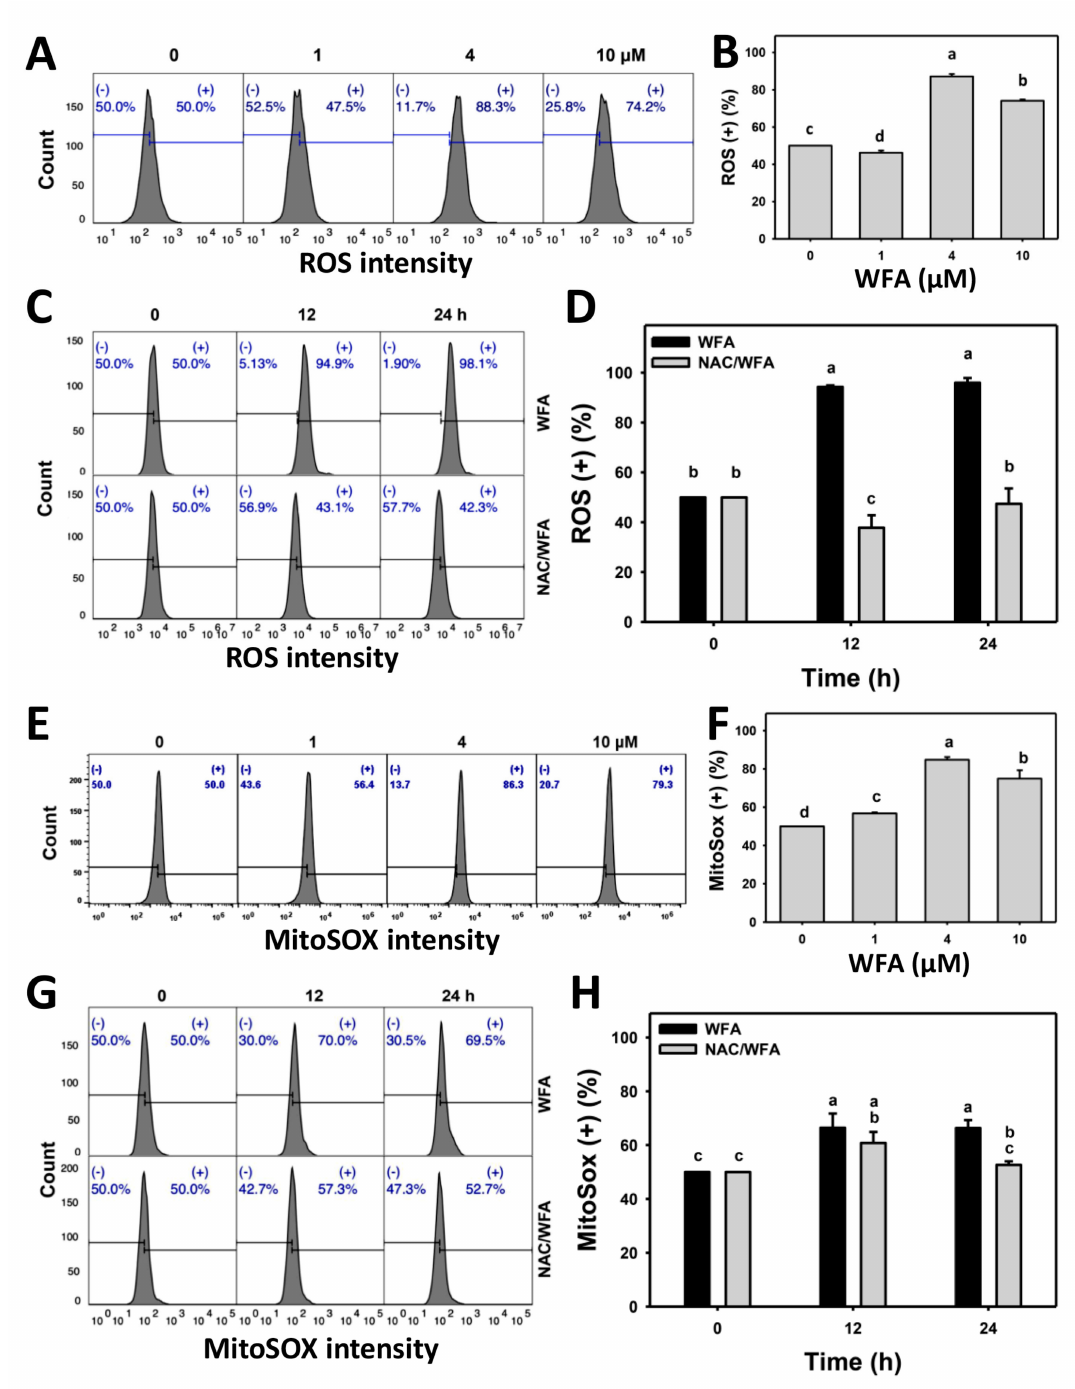
Figure 5. WFA induces ROS and MitoSOX generation in bladder cancer cells. ( A , B , E , F ) Patterns and statistics for ROS and MitoSOX changes. Bladder cancer cells (J82) were treated with WFA (24 h, 0 to 10 µ M), where the negative control for WFA (0 µ M) contained 0.1% DMSO. Symbol (+) indicates ROS or MitoSOX (+). ( C , D , G , H ) The pattern and statistics for NAC pretreated effect on ROS and MitoSOX expressions of J82 cells following WFA incubation. Cells were pretreated and post treated with NAC (8 mM, 1 h) and WFA (0 and 10 µ M for 12 and 24 h), respectively. Data, mean ± SD ( n = 3). Columns showing non-overlapping lower-case letters indicate p < 0.05 for multiple